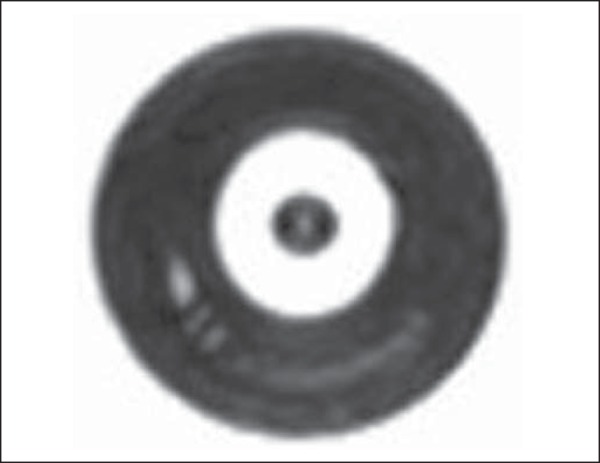
MRI scan (T2-weighted sequence) in which the CuSO4 dummy is
visualized in the ring lumen.